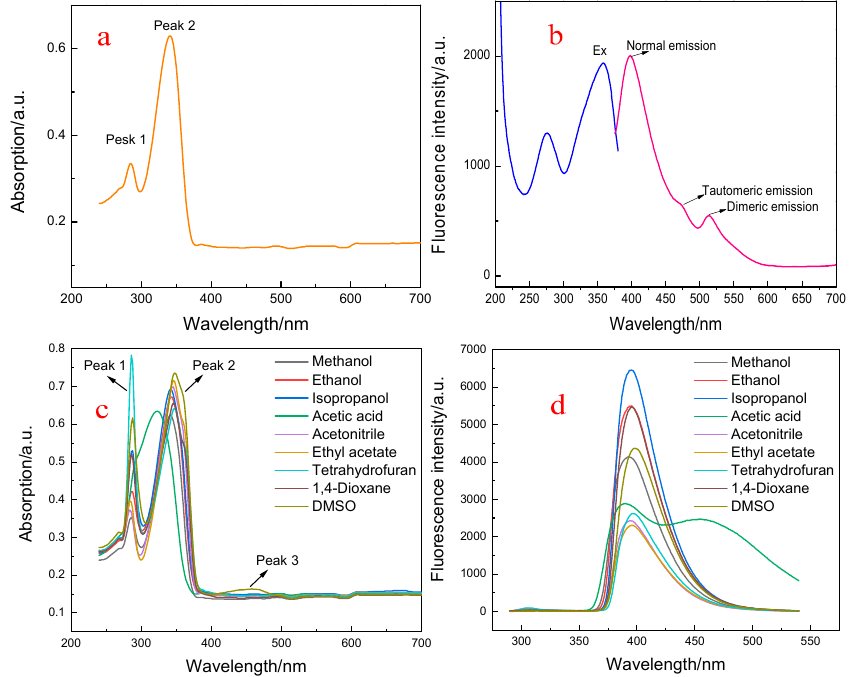
Figure 2. Absorption and fluorescence spectra of MLR. ( a ) Absorption spectrum of MLR in DMF − water mixed system (3/7, v / v ); ( b ) fluorescence spectra of MLR in the same DMF − water system; ( c ) UV-Vis spectra of MLR in different solvents (10 µ M); ( d ) fluorescence spectra of MLR in different solvents.